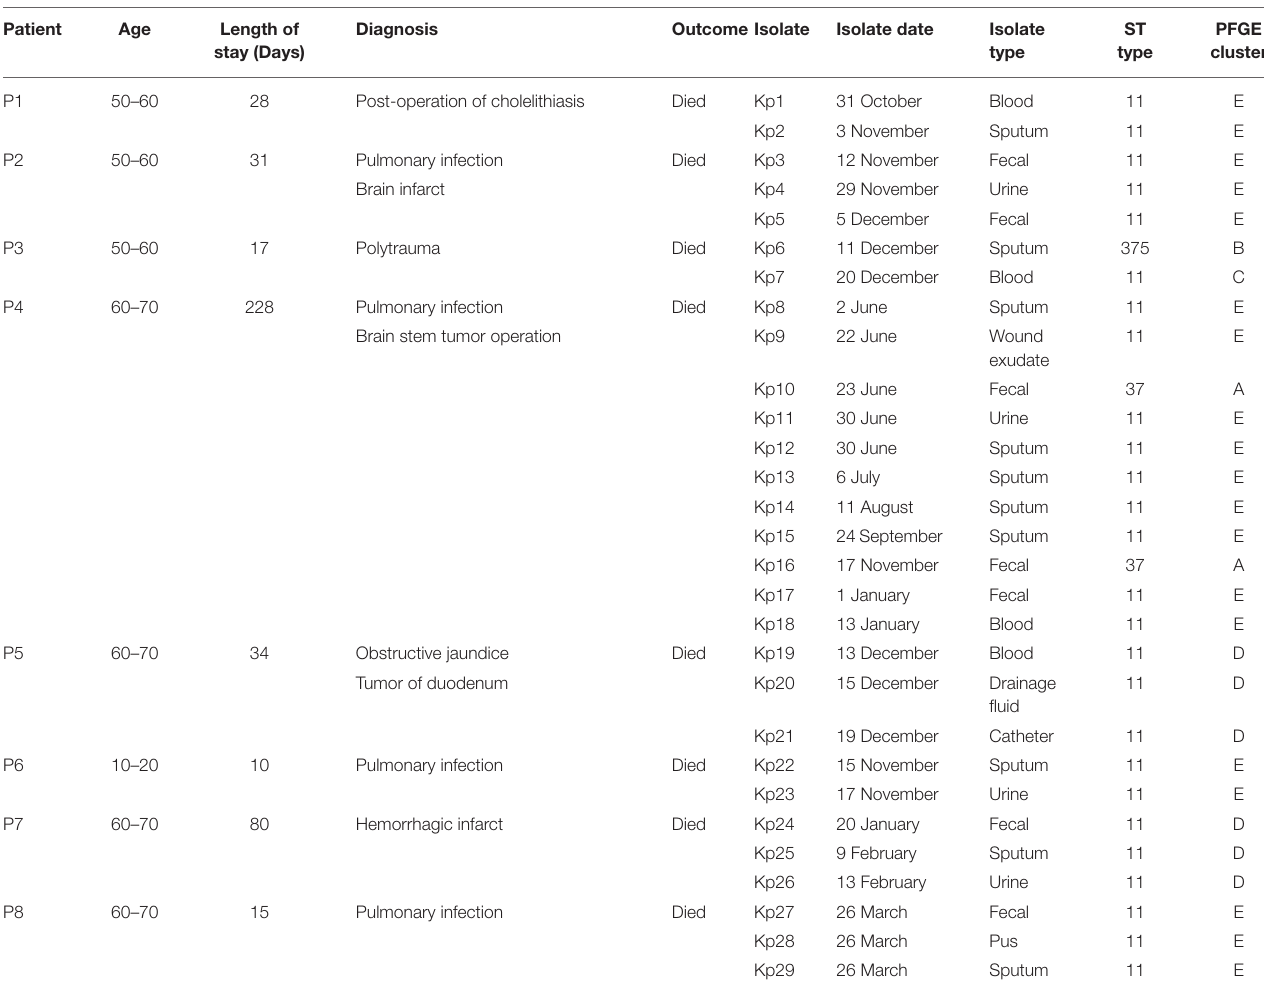
TABLE 1 | Characteristics of the eight patients and the isolated K. pneumoniae strains.